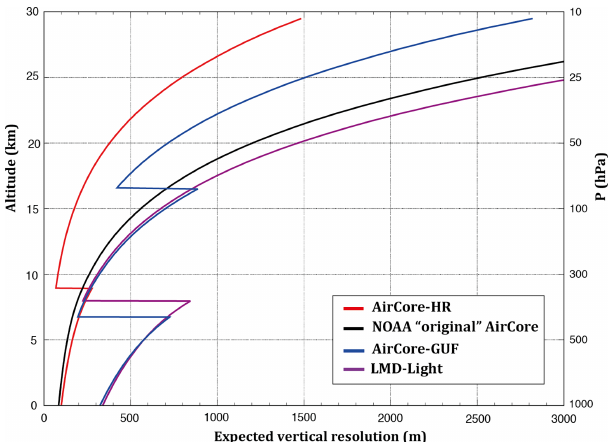
Figure 1. Calculated vertical resolution for CO 2 with the Goethe University Frankfurt (GUF) AirCore (AirCore-GUF) in compari- son to other AirCores (see text for description), assuming a delay of 3h between collection and sampling, a measurement flow of 40mLmin − 1 and an effective cell volume of 6mL. The AirCore- HR and LMD-Light AirCores are operated by LMD, while the orig- inal NOAA AirCore refers to the AirCore described by Karion et al.